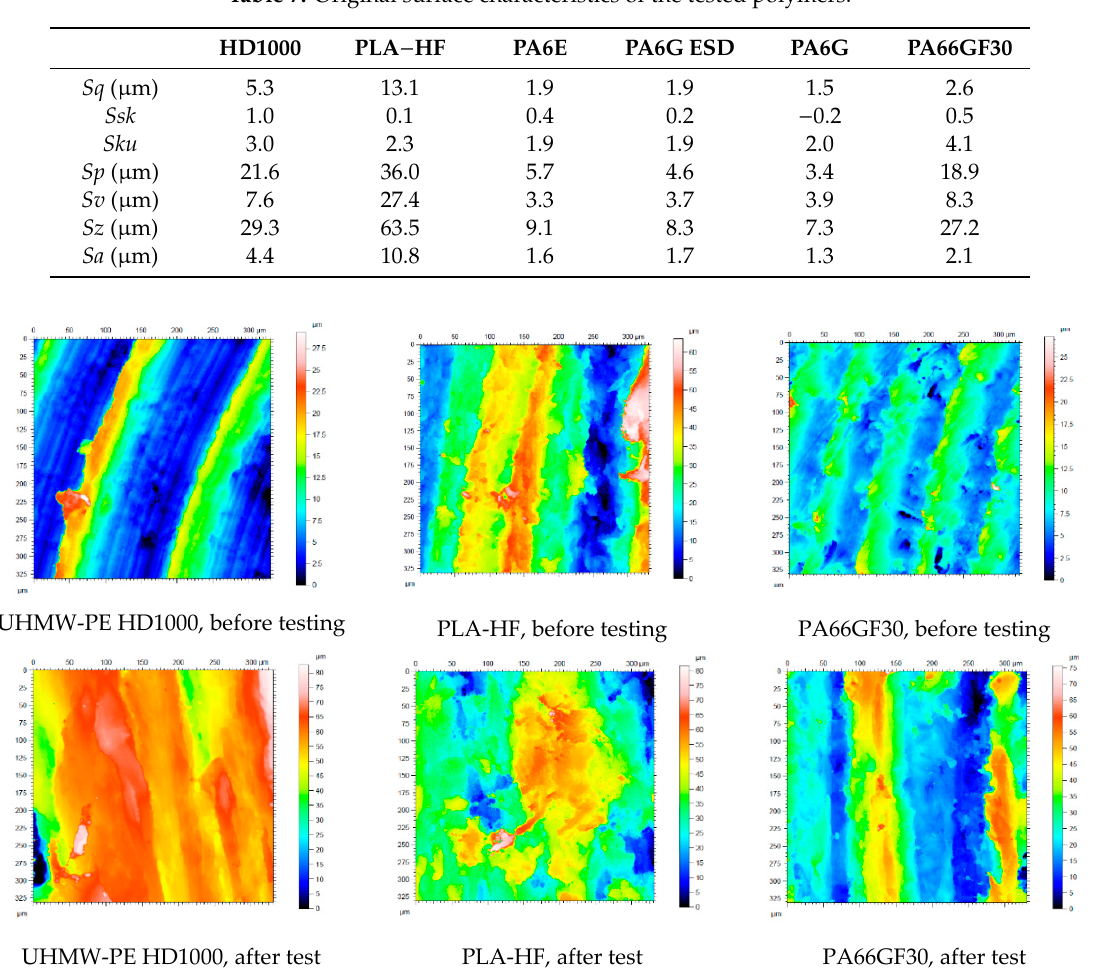
Table 8. Surface characteristics after the tests and the change in %.